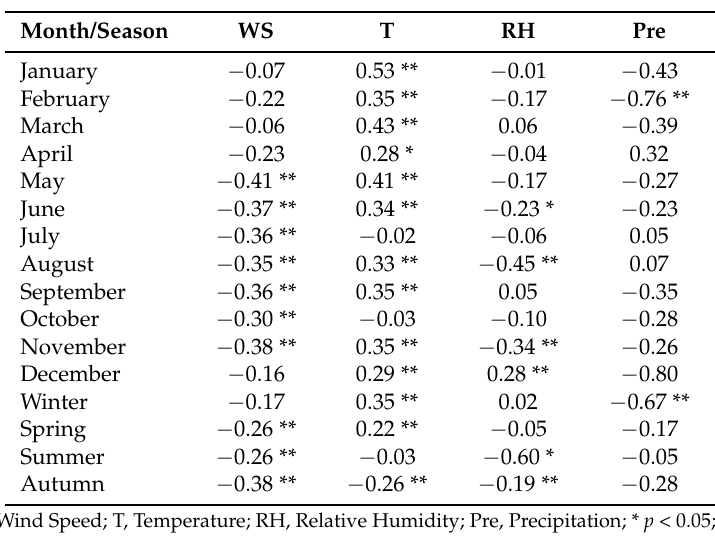
Table 3. The correlation coefficients of daily PM 2.5 related with meteorological variables.